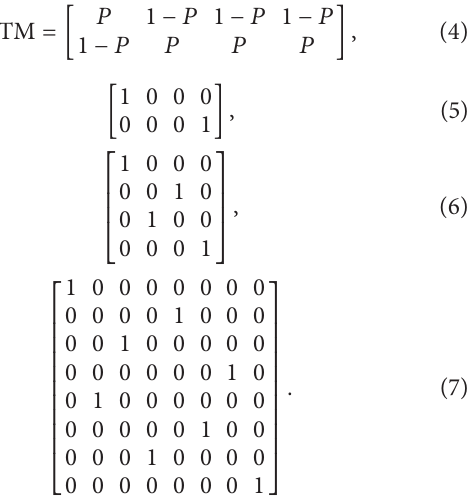
Figure 4: Conceptual representation of the desired